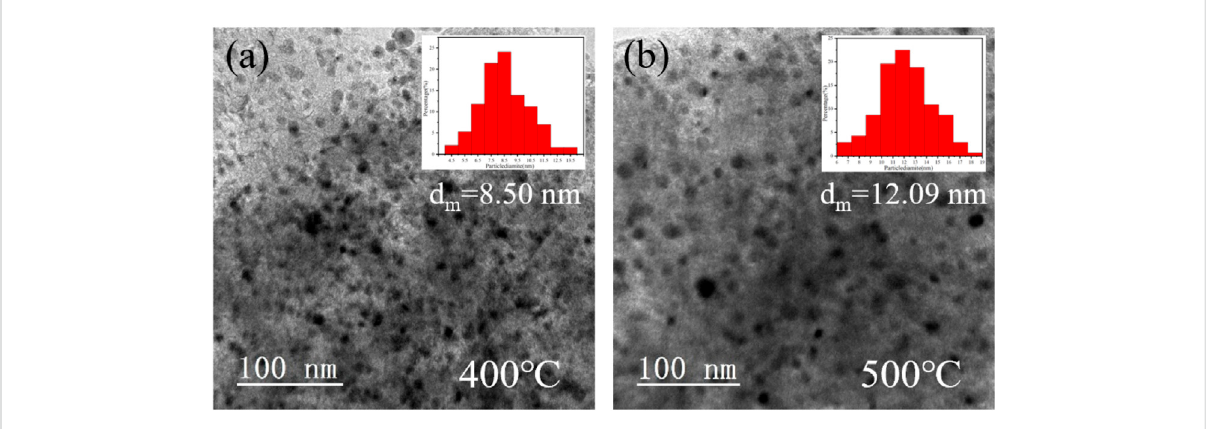
FIGURE 7 TEM images and particle size distributions of samples with different reduction temperatures (A) 400 ° C, (B) 500 °